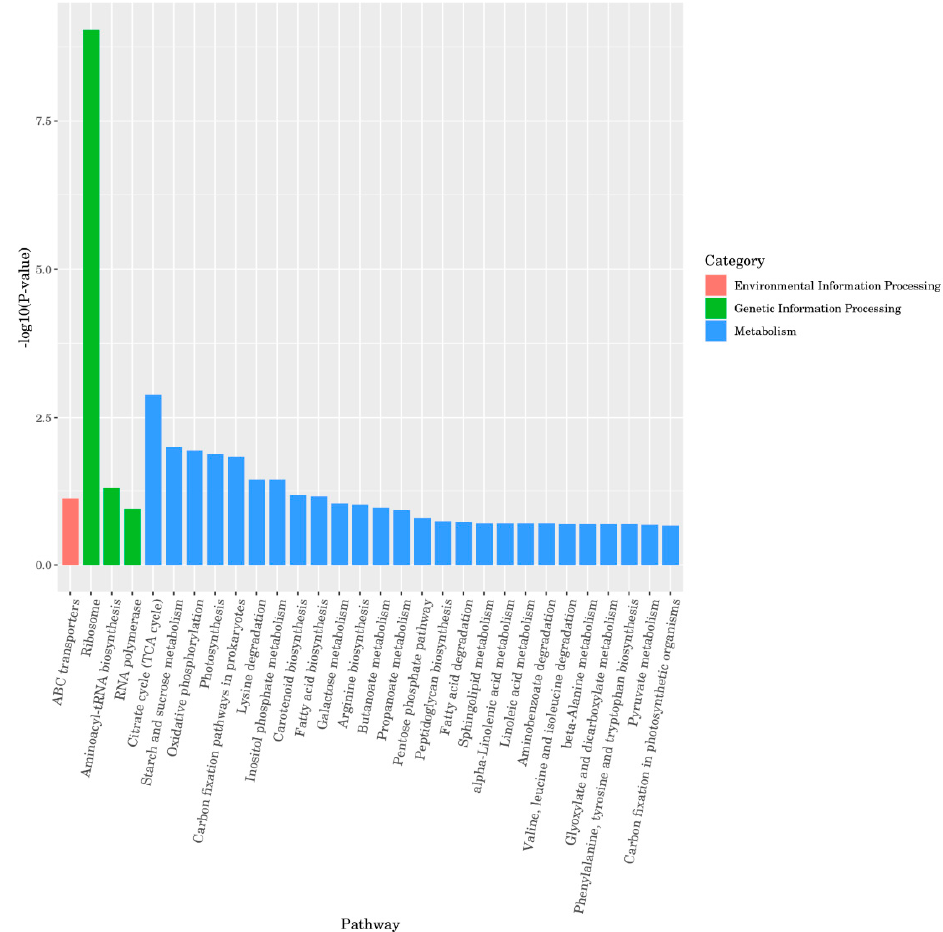
Figure 4. KEGG enrichment analysis of CS14 . Table 5. Drug resistance-related differentially expressed genes .